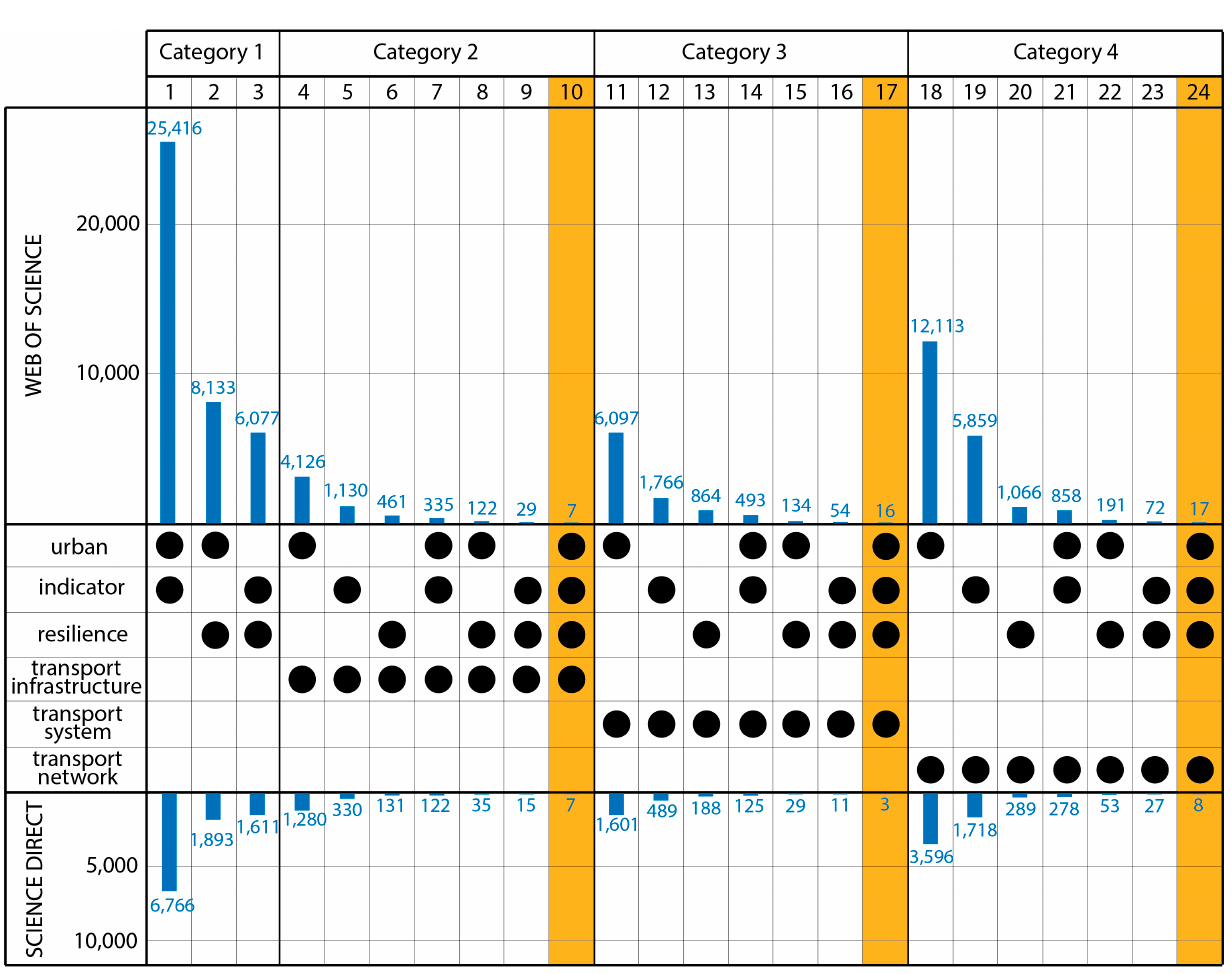
Figure 3. State of the art of the search work.